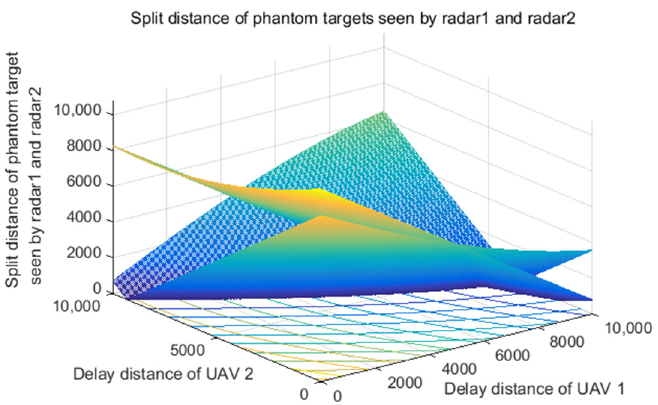
Figure 10. Split distance of phantom targets seen by radar 1 and radar 2.